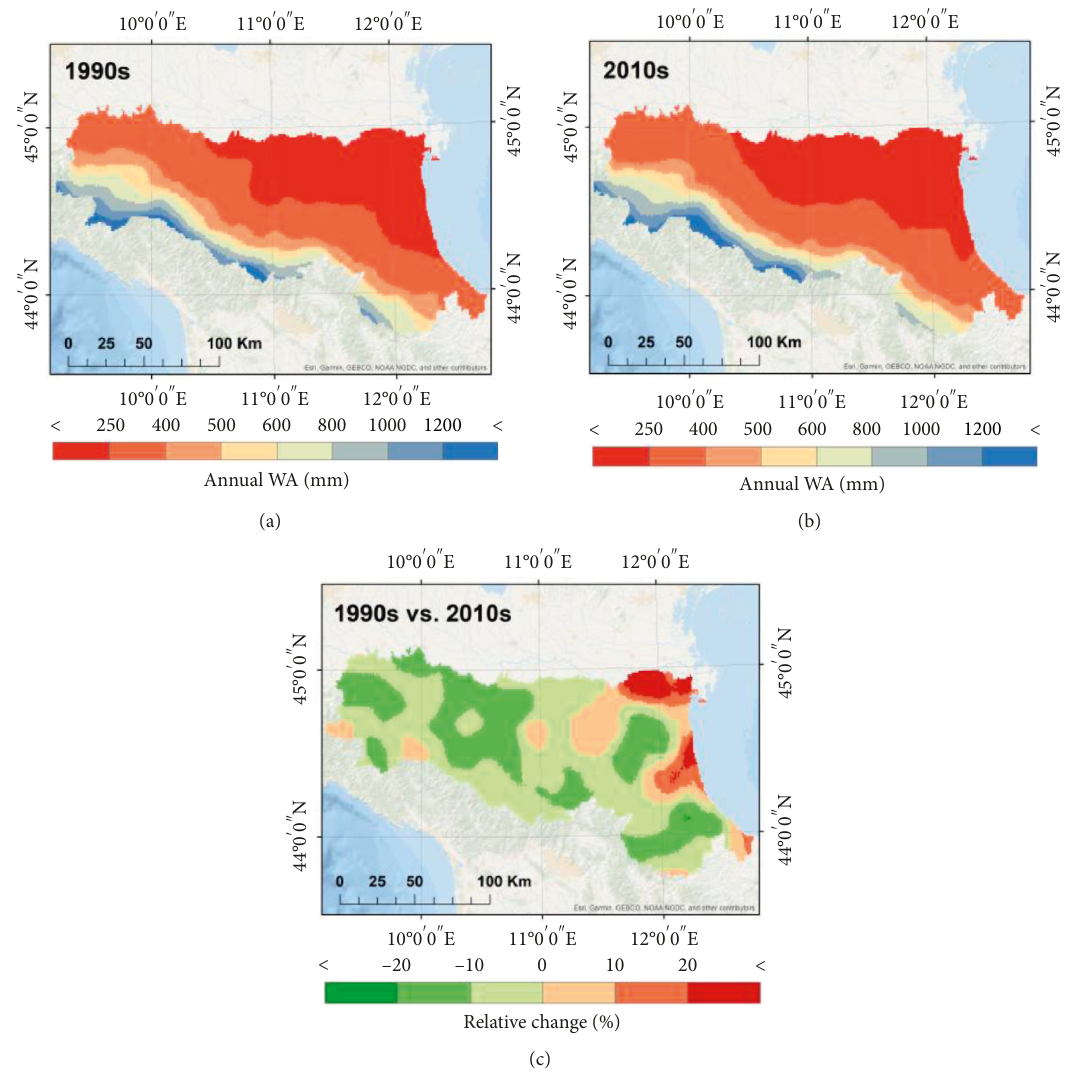
Figure 6: Spatial distribution of mean annual WA. (a) The average of mean annual WA between 1961 and 1990. (b) The average of mean annual WA between 1991 and 2015. (c) The relative changes in mean annual WA as a difference between the two time-periods. Background image source: Esri, Garmin, GEBCO, NOAA NGDC, and other